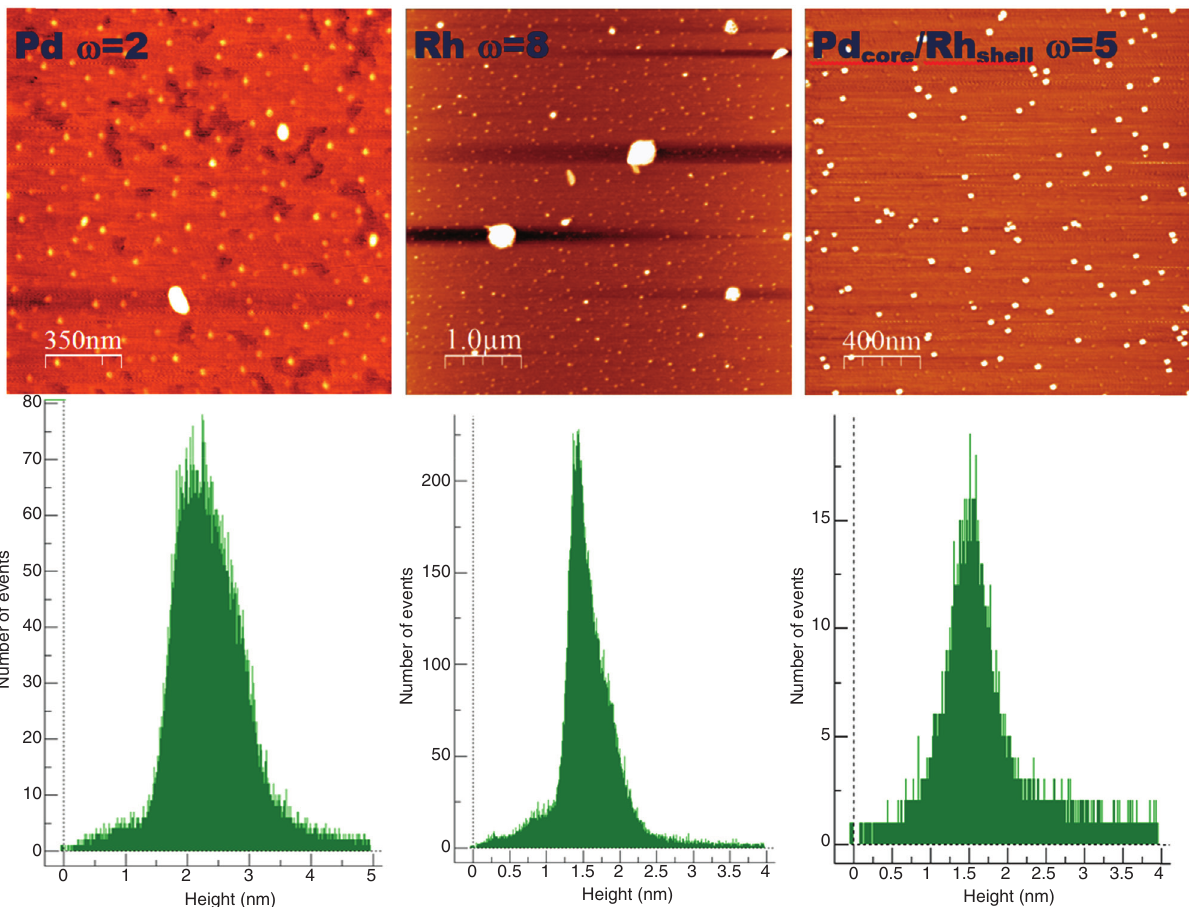
/Rh NPs ( ω = 5.0). core shell